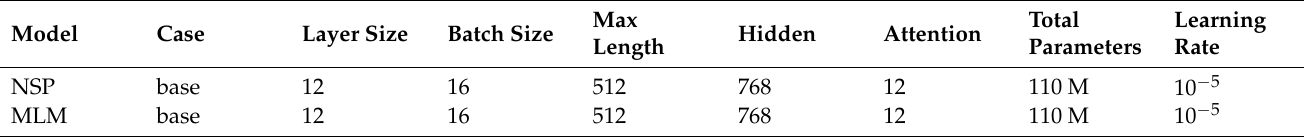
Table 3. Hyper-parameter settings for NSP and MLM